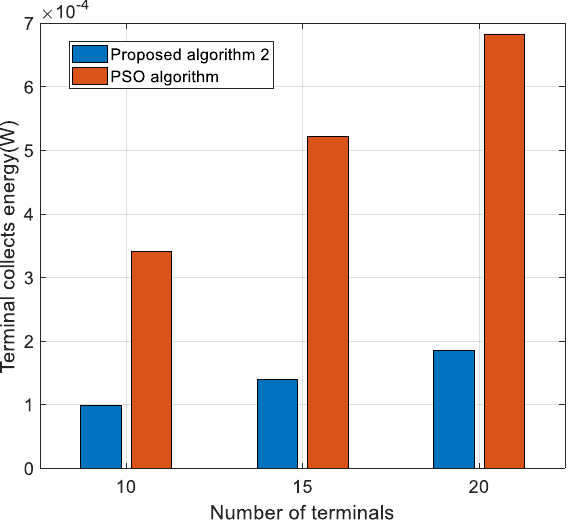
Figure 9. Terminal collects energy versus the number of terminals for different algorithms.